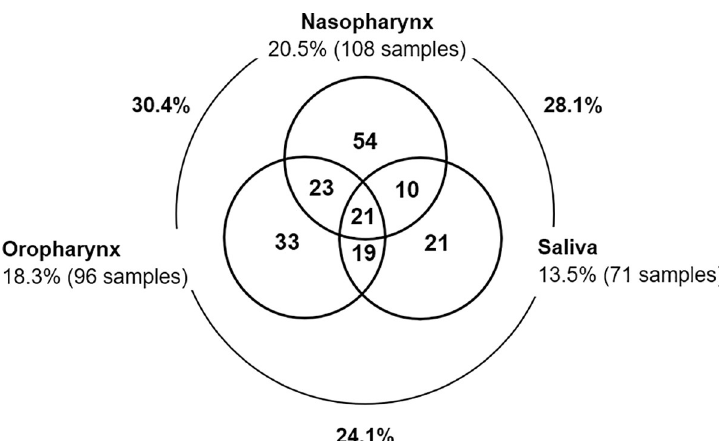
Fig 1. Positive sites for S . aureus among the 526 sampling time-points in which three sampling sites (nasopharynx, oropharynx, and saliva) were screened. There were 345 sampling time-points in which the three sampling sites were negative for S . aureus . Each circle represents the indicated sampling site. The numbers inside circles indicate the number of positive samples for S . aureus . Overlapping areas indicate the number of positive samples in which simultaneously detection of S . aureus in more than one sampling site occurred. Percentages of positive samples are indicated, as well as concordance between sampling sites.